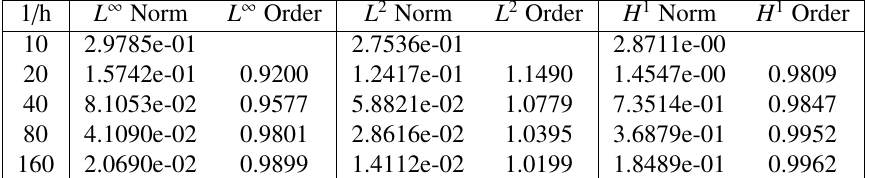
Table 3. Errors and Convergence Rate for Quadratic IFEM-BE Approximation for Example 1 Table 6. Errors and Convergence Rate for Linear IFEM-BE Approximation for Example 2